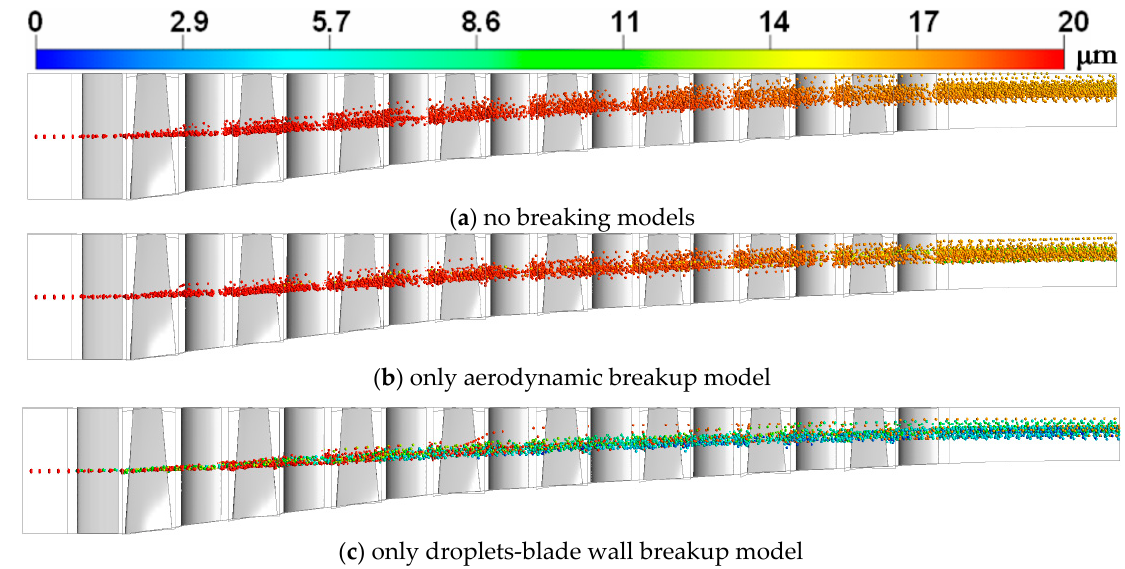
Figure 13. Droplets trajectories of 20 μ m inject from inlet 50% span under 90% rotating speed.